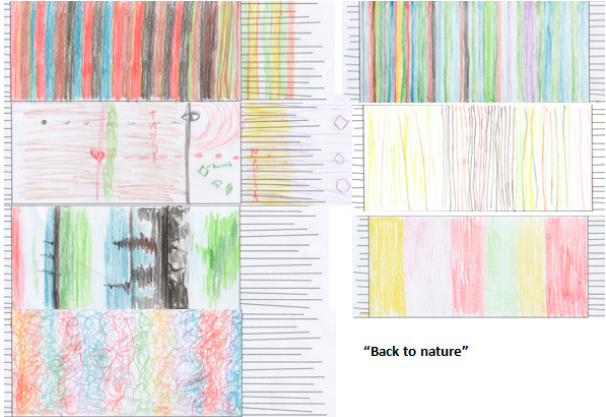
Figure 2. The seven rugs that forms the group “Back to nature”.